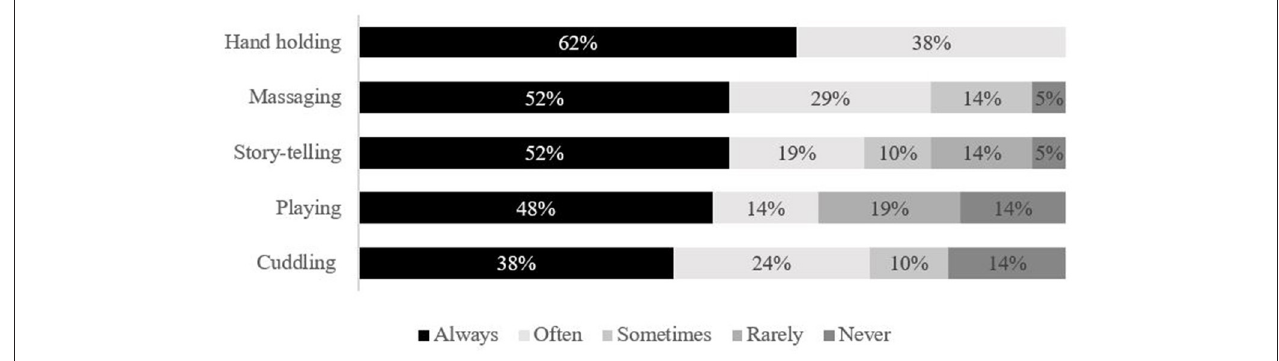
FIGURE 10 | Family primary interaction with child in PICU (peer mentor, pre-survey).